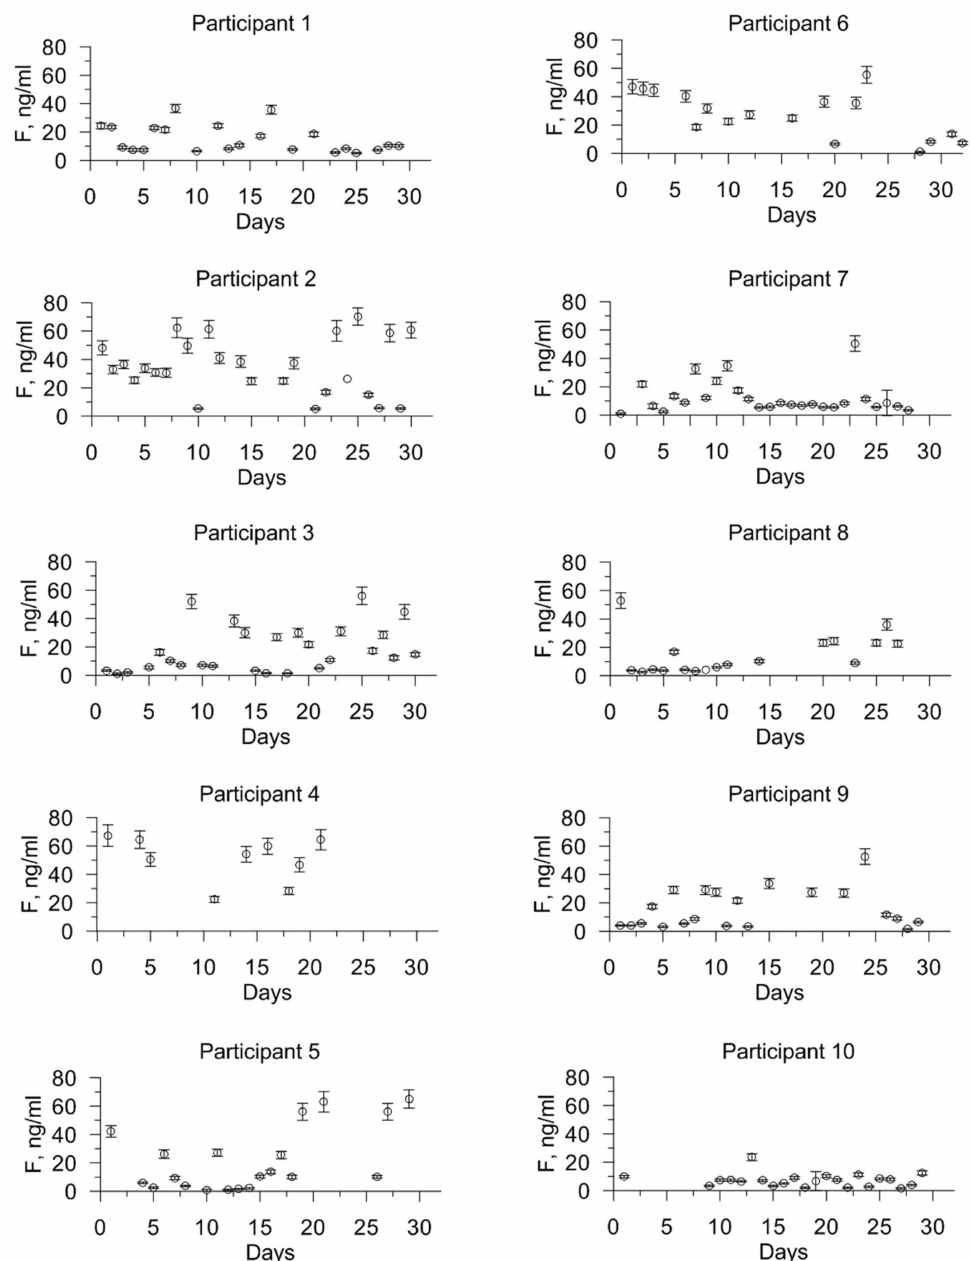
Figure 5. Profiles of changes in the concentration of cortisol in saliva sampled in the morning immediately after waking up for a month for each study